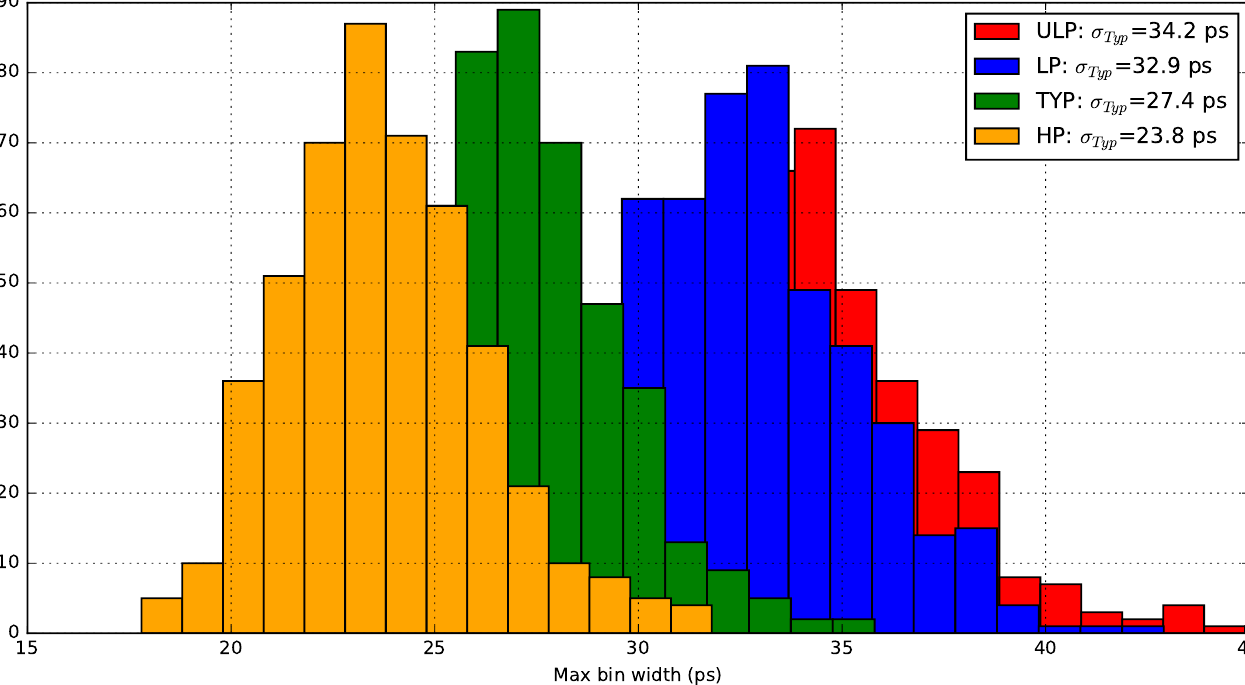
Figure 13. Maximum bin width for each MATRIX16 channel sample (without